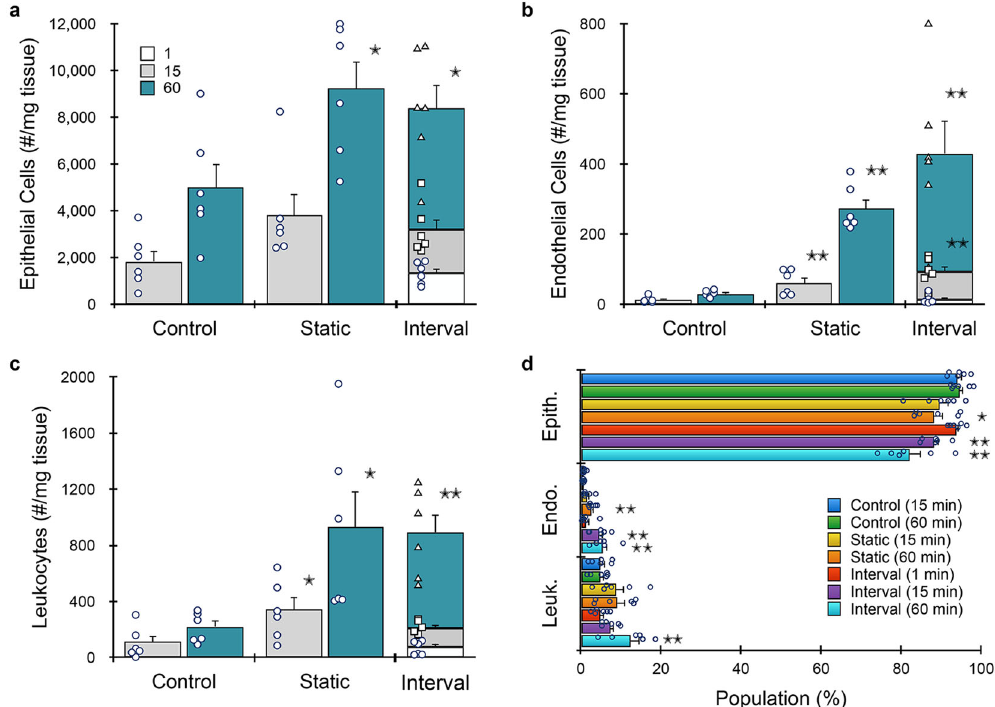
Fig. 5 Micro fl uidic platform results for murine breast tumor. Breast tumors from MMTV-PyMT mice ( n = 6) were resected, minced, processed with the micro fl uidic platform, and analyzed by fl ow cytometry. a EpCAM + epithelial cells were ~2-fold higher at both time points. b Endothelial cells were enhanced even more by the micro fl uidic platform, with fi ve- and ten-fold more cells recovered after 15 and 60 min, respectively. c Leukocytes increased by three- and fi ve-fold after 15 and 60 min, respectively. The interval format produced similar total cell numbers relative to the corresponding static time point, except for endothelial cells, which were slightly higher. d Population distributions obtained for each processing condition. Device processing enriched both endothelial cells and leukocytes at all but the 1 min time point. Data are presented as mean values± SEM from at least three independent experiments. Circles indicate values for experimental replicates. For stacked plots, experimental replicates are indicated by circles at 15 min, squares at 30 min, and triangles at 60 min. Two-sided T test was used for statistical testing. Stars indicate p < 0.05 and double stars indicate p < 0.01 relative to the control at the same digestion time. p values for all comparisons are presented in the Source Data fi